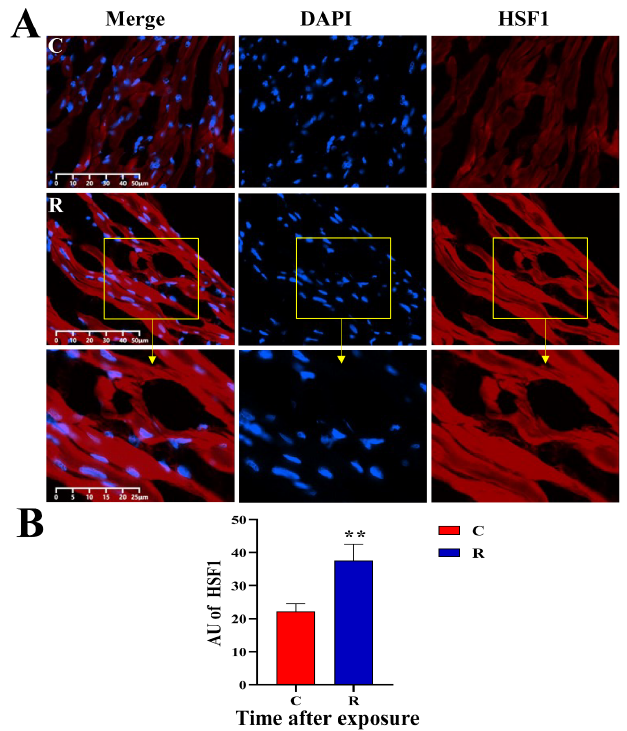
Figure 16. Changes in HSF1 expression and distribution of rats’ myocardium after S-band radiation. ( A ) Original graph of IF; ( B ) statistical analysis graph of AU. Significance signs were classified according to p -value: ** p < 0.01. The yellow box is the magnified area.